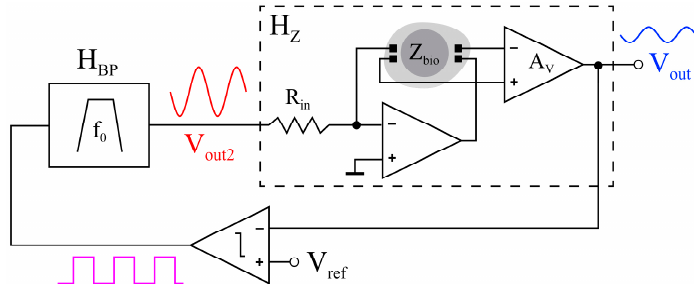
Figure 1. Bioimpedance self-stimulated monitoring system based on an oscillation-based test (OBT) [16]. H BP is the Band-Pass filter, and Z bio is the biological impedance.